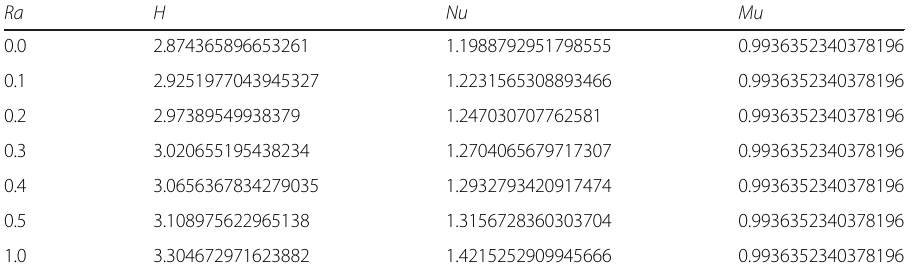
Table 6 Values of skin friction (H), Nusselt number ( Nu ), and Sherwood number ( Mu ) for different values of Ra Ra